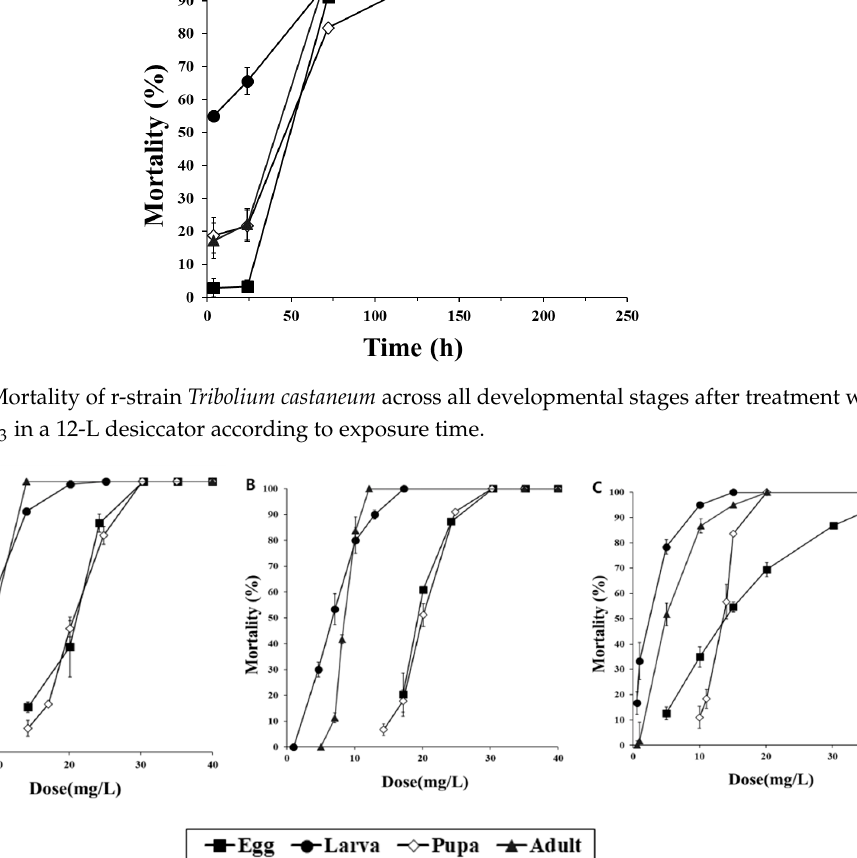
Figure 3. Mortality of ( A ), d ‐ strain Tribolium castaneum , ( B ), r ‐ strain T . castaneum and ( C ), Oryzaephilus surinamensis eggs, larvae, pupae and adults after 24 h of exposure to the carbonyl sulfide (COS) fumigant in a 12 ‐ L desiccator.